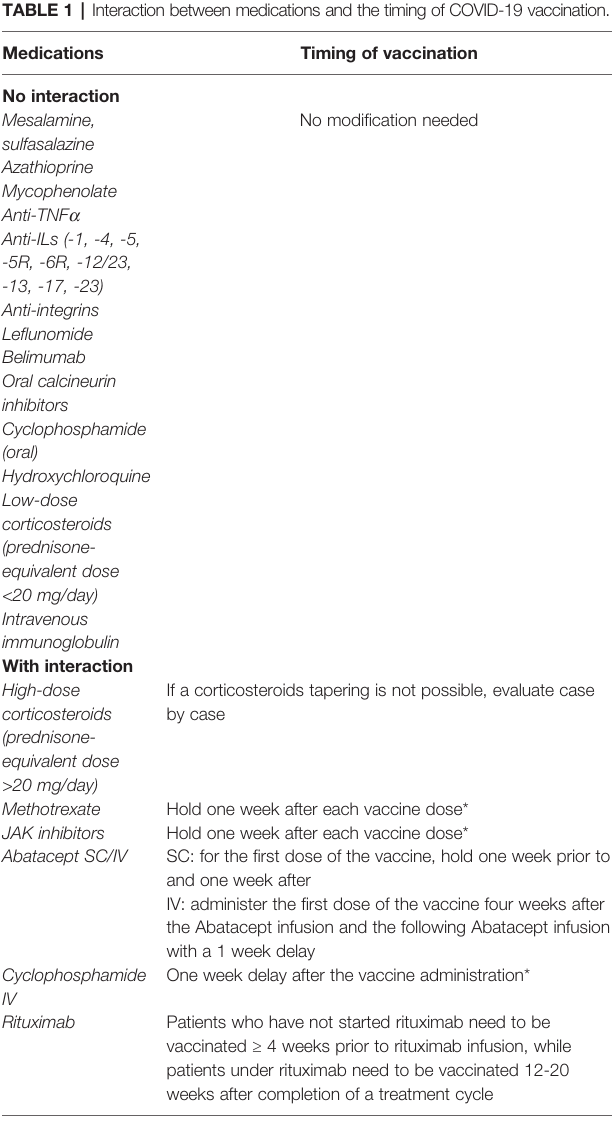
TABLE 1 | Interaction between medications and the timing of COVID-19 vaccination. Medications Timing of